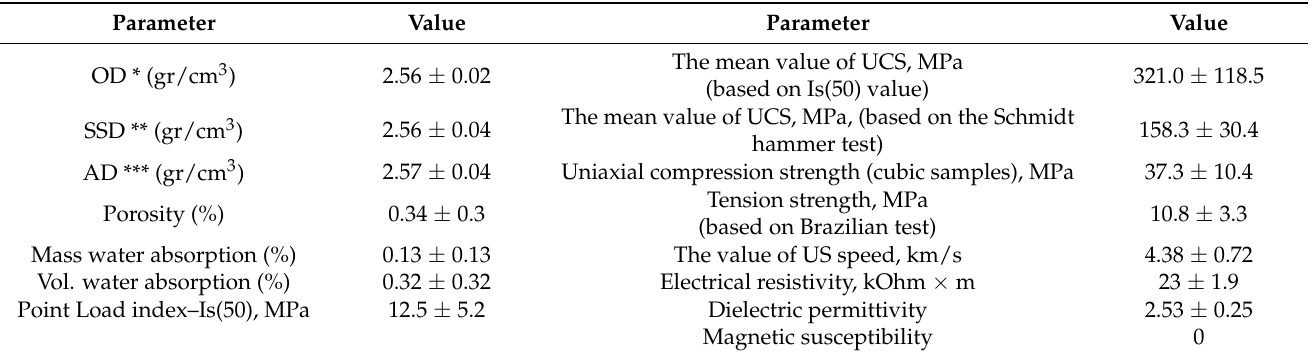
Table 1. The value of physical-mechanical parameters of chert gravels.